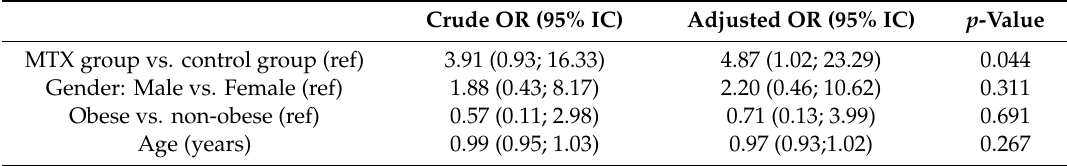
OR: Odds ratio. Ref: